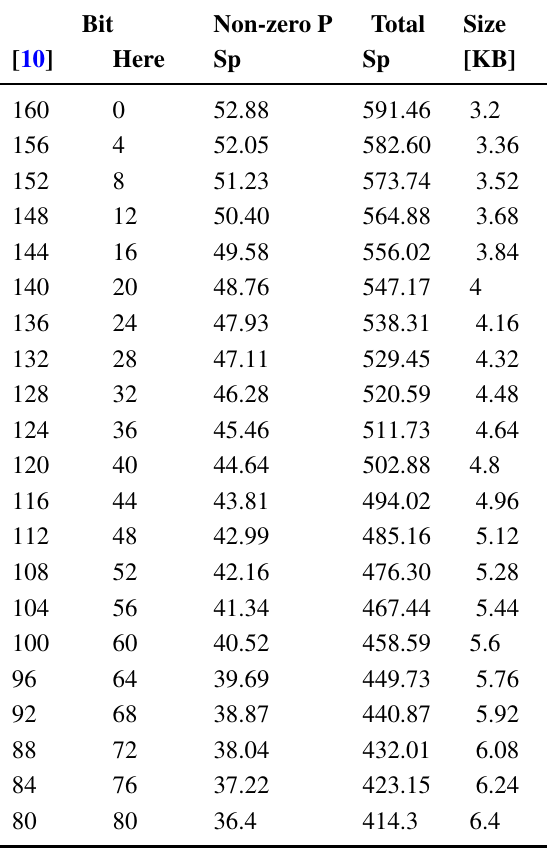
Table 3. Performance evaluation for hybrid model in the case of our speed-optimized 2NAF; the bit section indicates the ratio of bits using our method and that of [10], respectively. Non-zero P: non-zero point, SP: speed optimized.